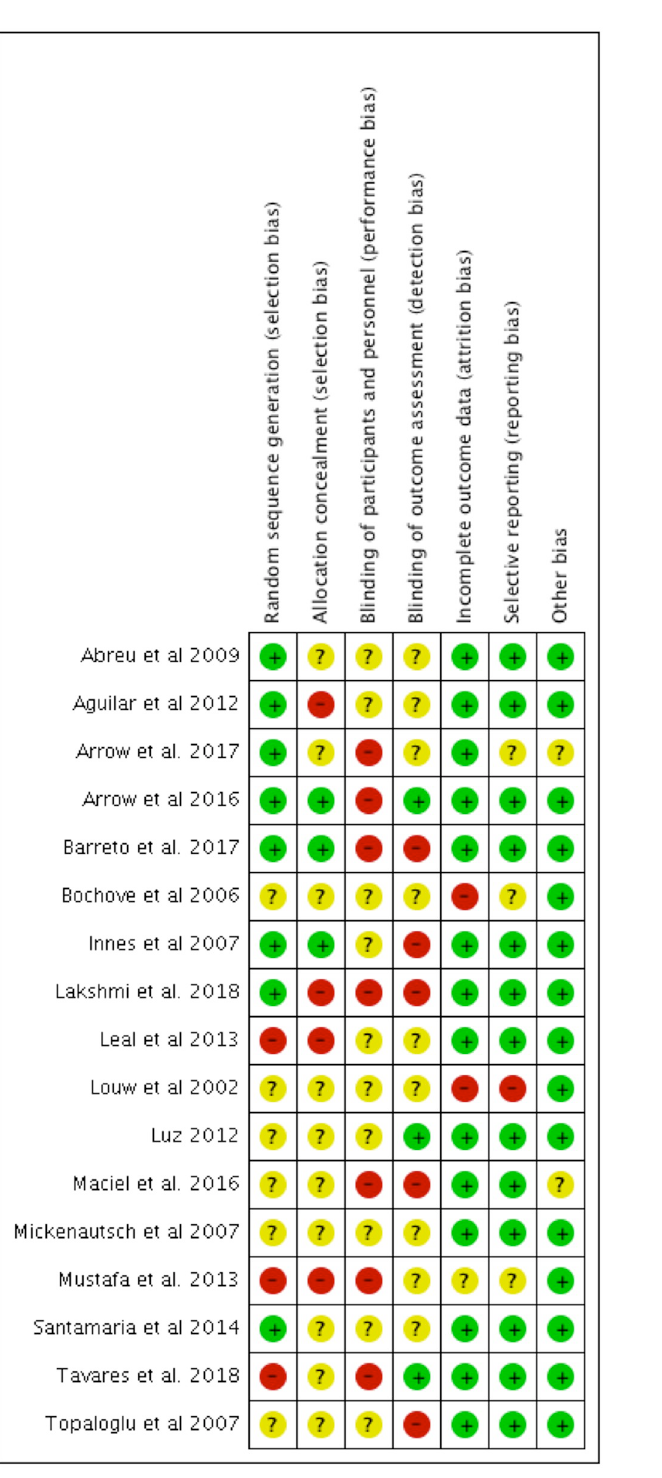
PLOS ONE | https://doi.org/10.1371/journal.pone.0208437 December6,